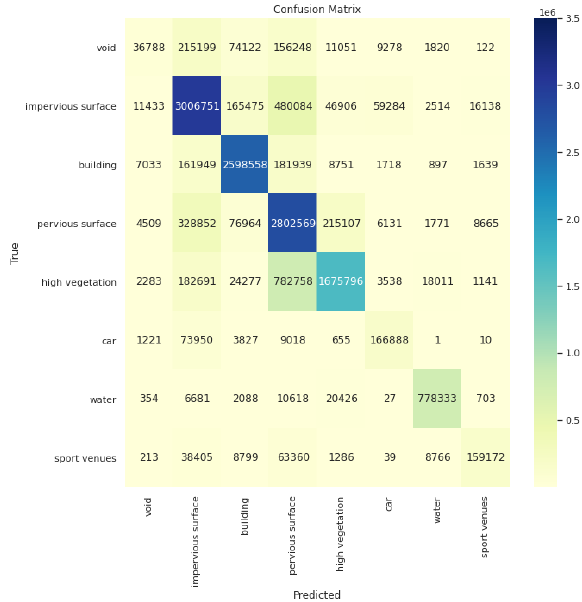
Table 2. Summary of accuracy values and training time for the proposed and baseline approaches